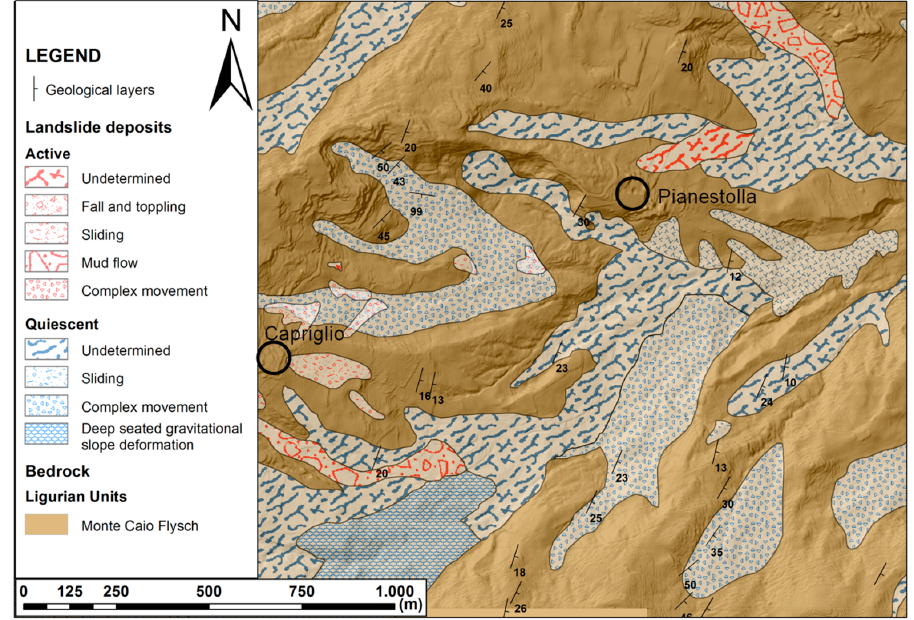
Figure 2. Geological map of the landslide area, including the locations of Capriglio and Pianestolla villages, and the landslide deposits [34].